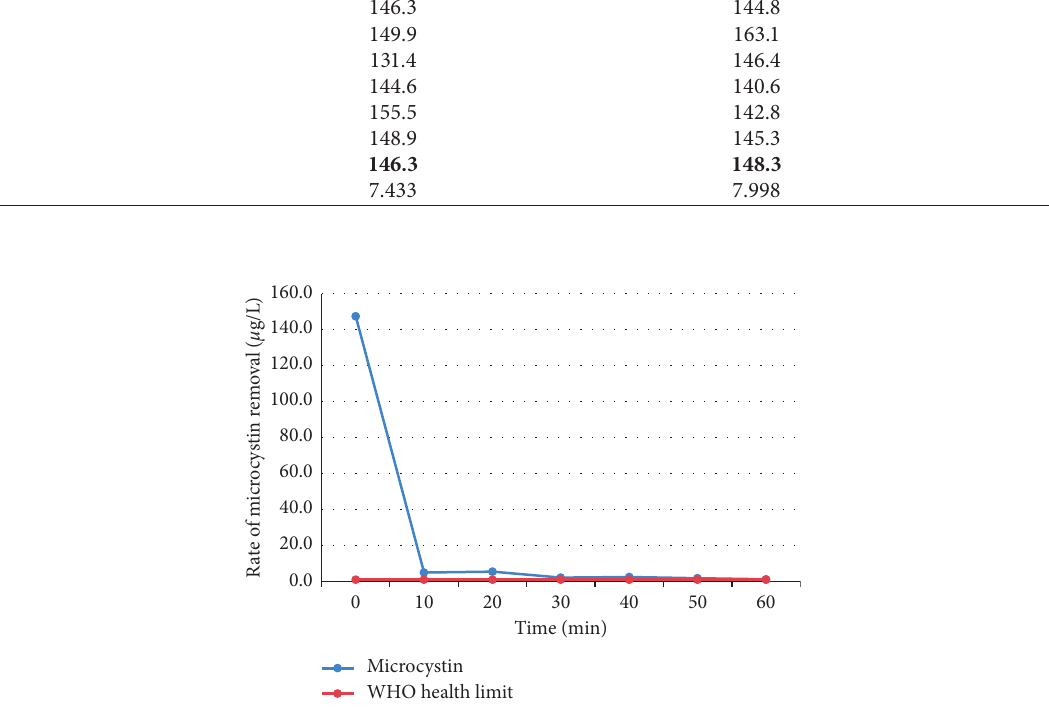
Figure 5: Rate of electrocoagulation removal of microcystin compared with WHO health advisory